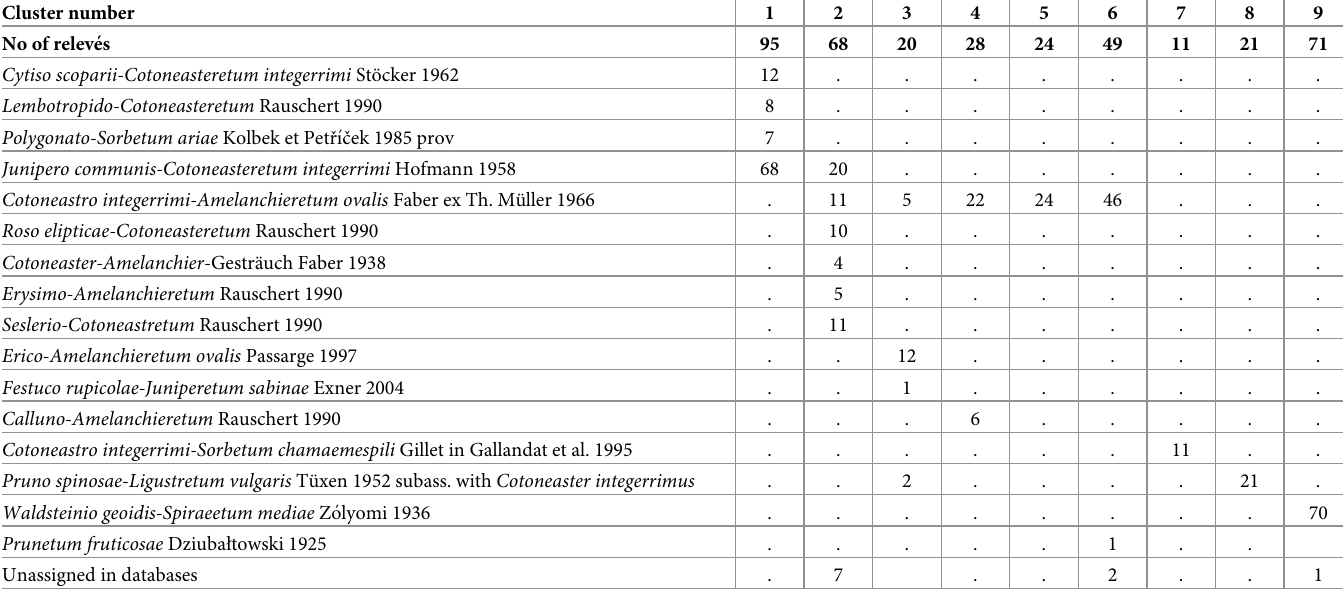
Table 2. The number of releve´s originally assigned by their authors to different syntaxonomical units in the clusters distinguished in this study. The numbers of clusters are compatible with Fig 2. Cluster number